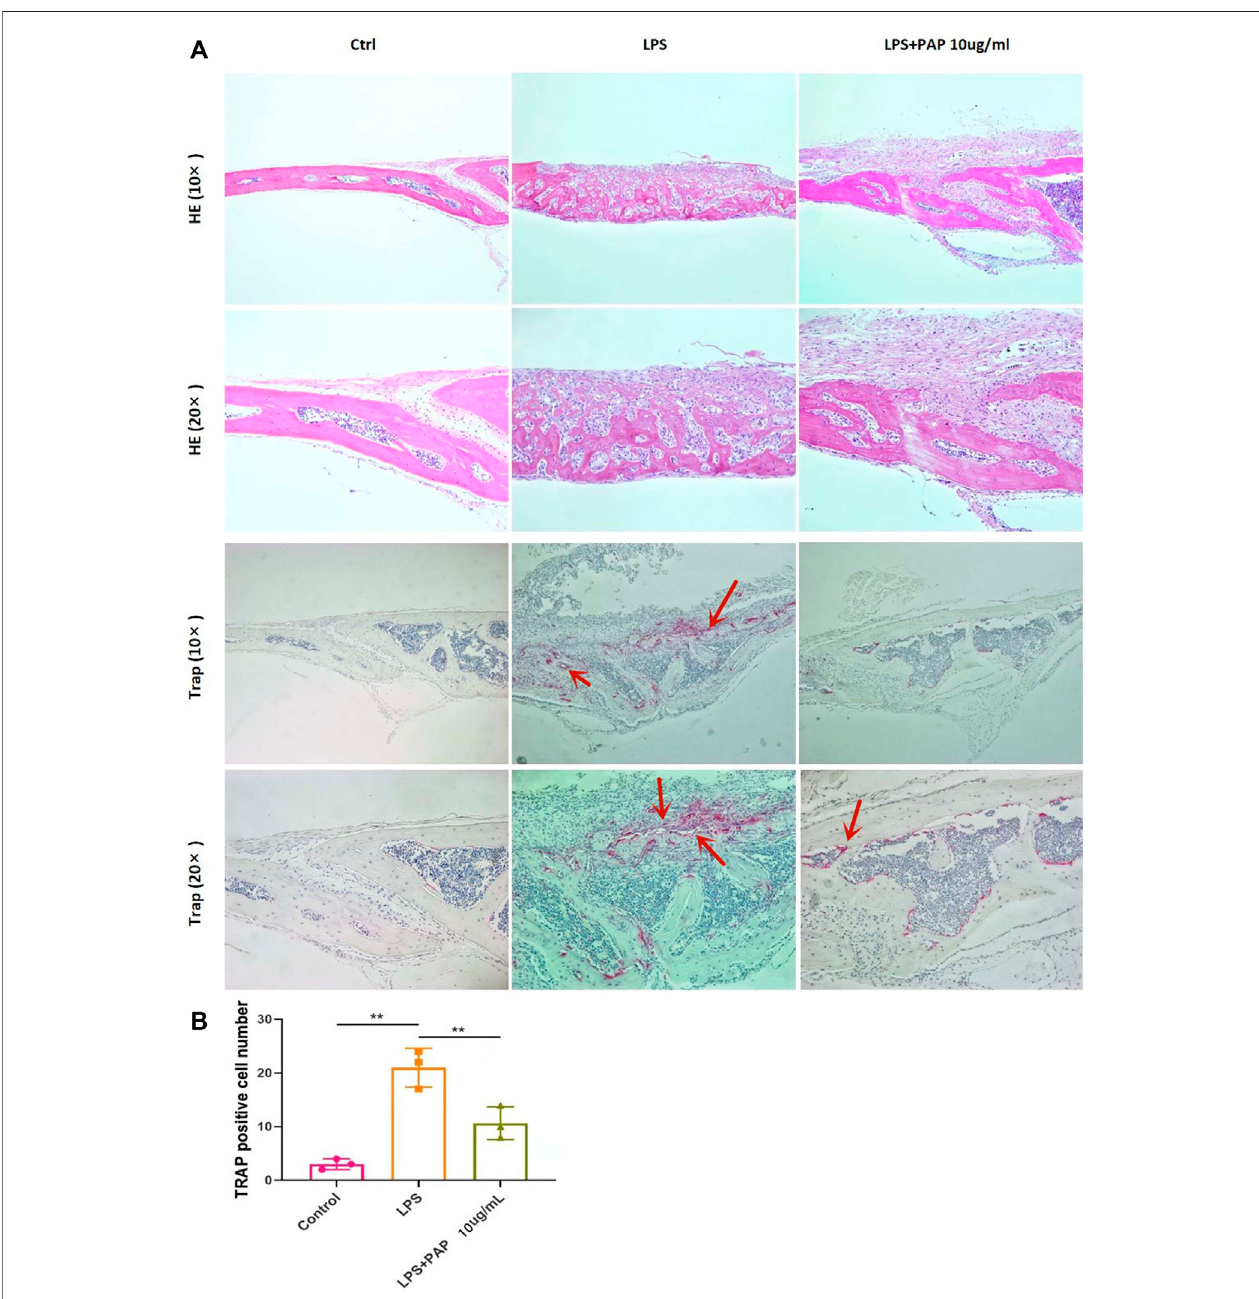
FIGURE 5 | Hematoxylin and eosin (H,E) and TRAP staining of cranial bone absorption (A) Representative images of H&E and TRAP staining; red arrow indicates osteoclasts (B) Quantitative analysis of TRAP-positive cells. **p < 0.01.